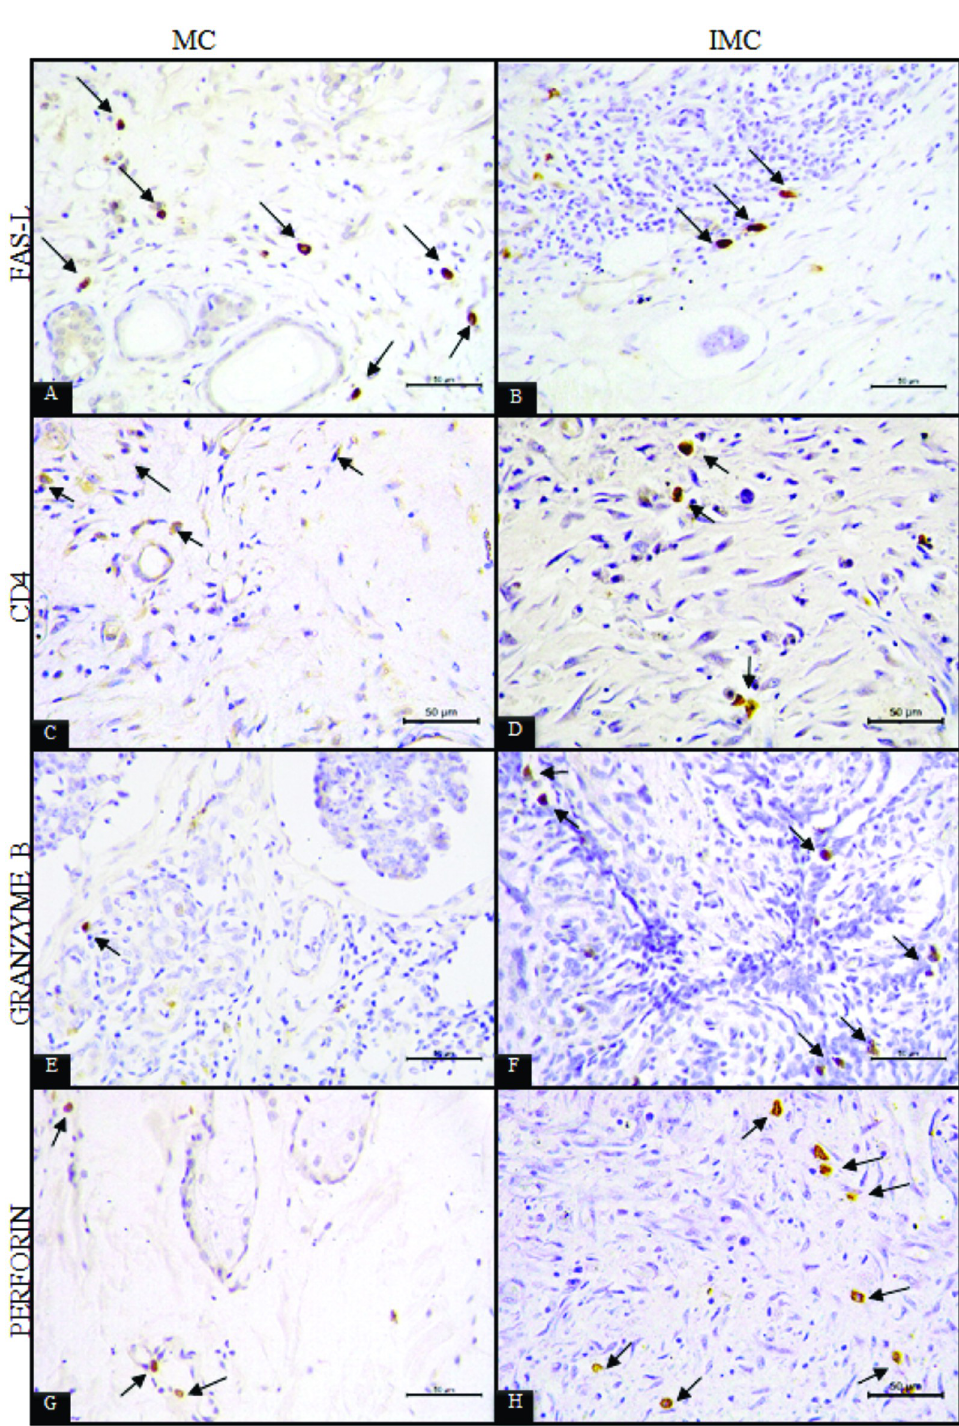
Fig 5. Photomicrography of immunohistochemically-stained sections. A) inflammatory cells positive for cytoplasmic expression of FAS-L in peritumoral inflammatory infiltrates of mammary carcinoma (MC) tissue. B) Inflammatory cells positive for cytoplasmic expression of FAS-L in peritumoral inflammatory infiltrates of inflammatory mammary carcinoma (IMC) tissue. C) Inflammatory cells positive for membrane expression of CD4 in the peritumoral inflammatory infiltrate of mammary carcinoma (MC) tissue. D) Inflammatory cells positive for membrane expression of CD4 in the peritumoral inflammatory infiltrate of inflammatory mammary carcinoma (IMC) tissue. E) Inflammatory